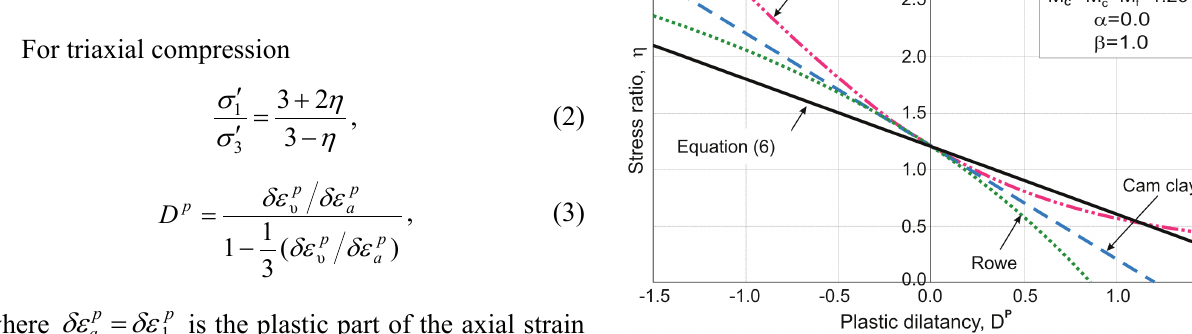
Fig. 1. Comparison of different stress ratio-plastic dilatancy relationships for sand